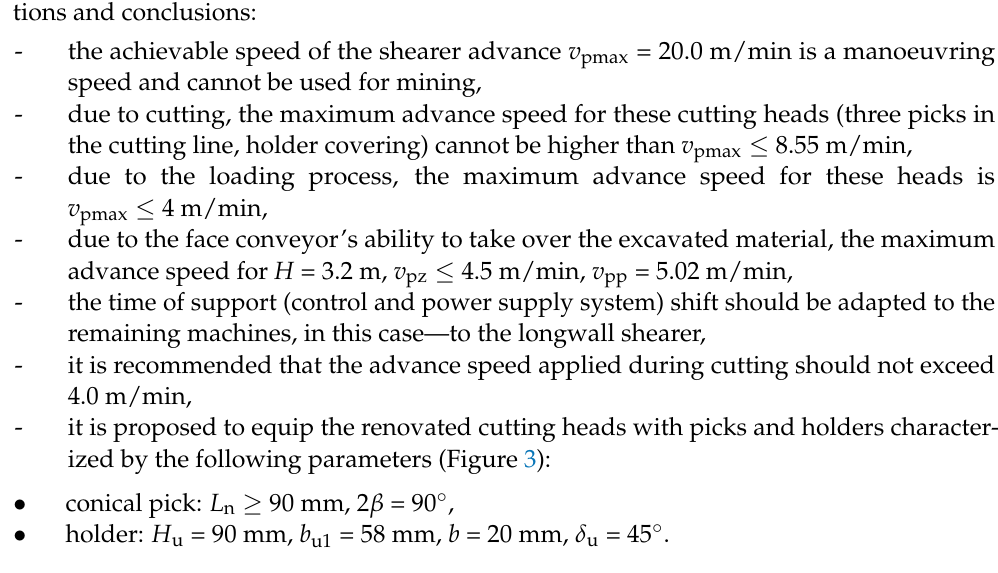
Table 3. Summary of average values of power N and force P z for various pick arrangements.